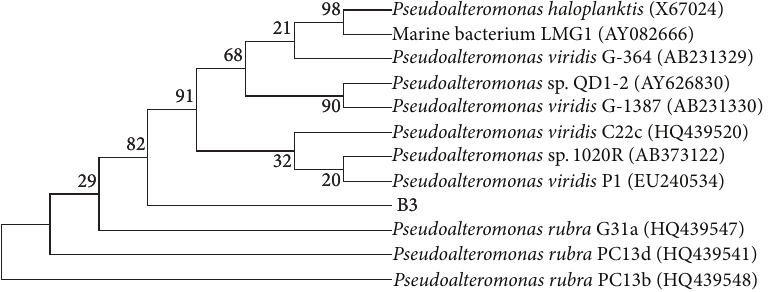
Figure 3: Phylogenetic tree of strain B3 based on 16S rDNA. The numbers at the nodes indicate the bootstrap level based on the analysis of 1000 resampled data sets.